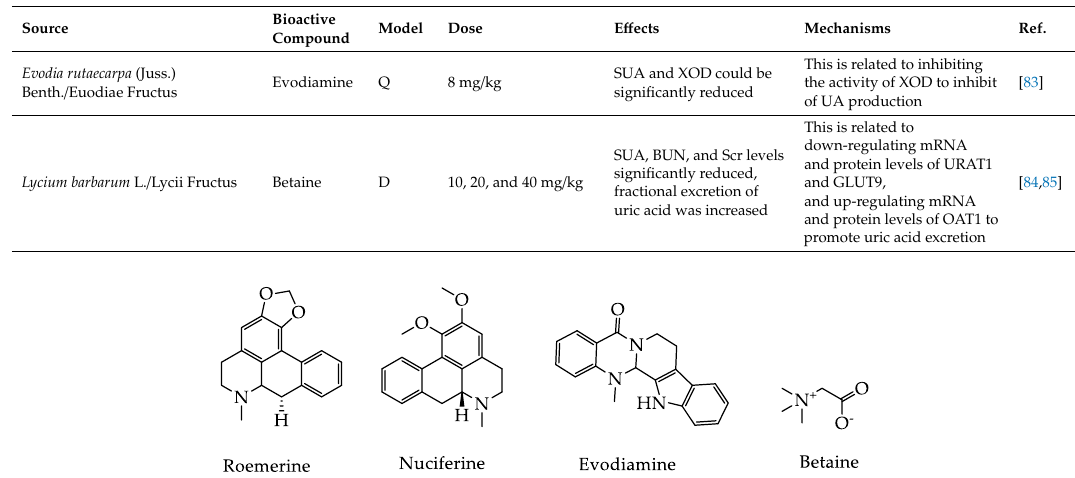
Table 5. Experiment and mechanism of alkaloids bioactive components from plant-based functional foods on hypouricemia.